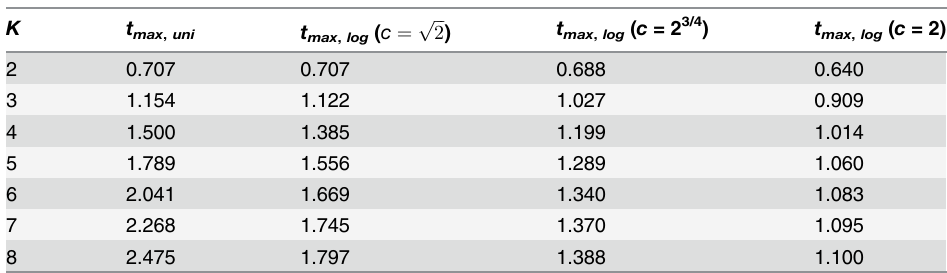
Table 3. Numerical values for the temporal delay of the local maximum in units of kernels obtained by coupling K truncated exponential kernels in cascade in the cases of a uniform distribution of the intermediate temporal scale levels τ k = k τ / K or a logarithmic distribution τ k = c 2( k − K ) τ with c > 1. Temporal delays from the maxima of time-causal